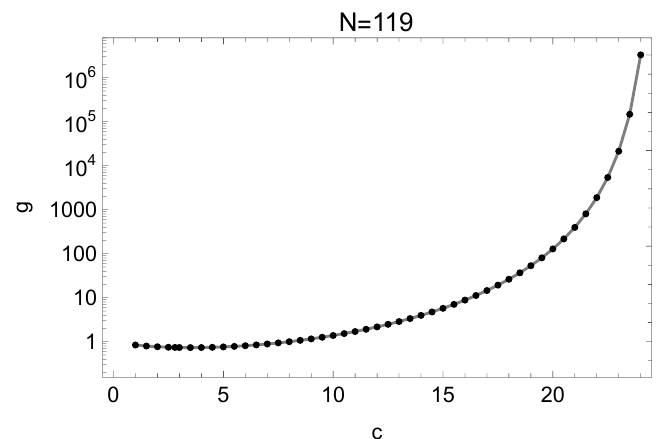
Figure 12. The upper bound on the g -function for stable boundary conditions as a function of central charge for c ≤ 25 . The bound diverges as c approaches 25 as that is the point at which the h gap ≥ c − 1 threshold needed for the existence of the upper bound starts to exceed the stability 24 threshold h gap = 1